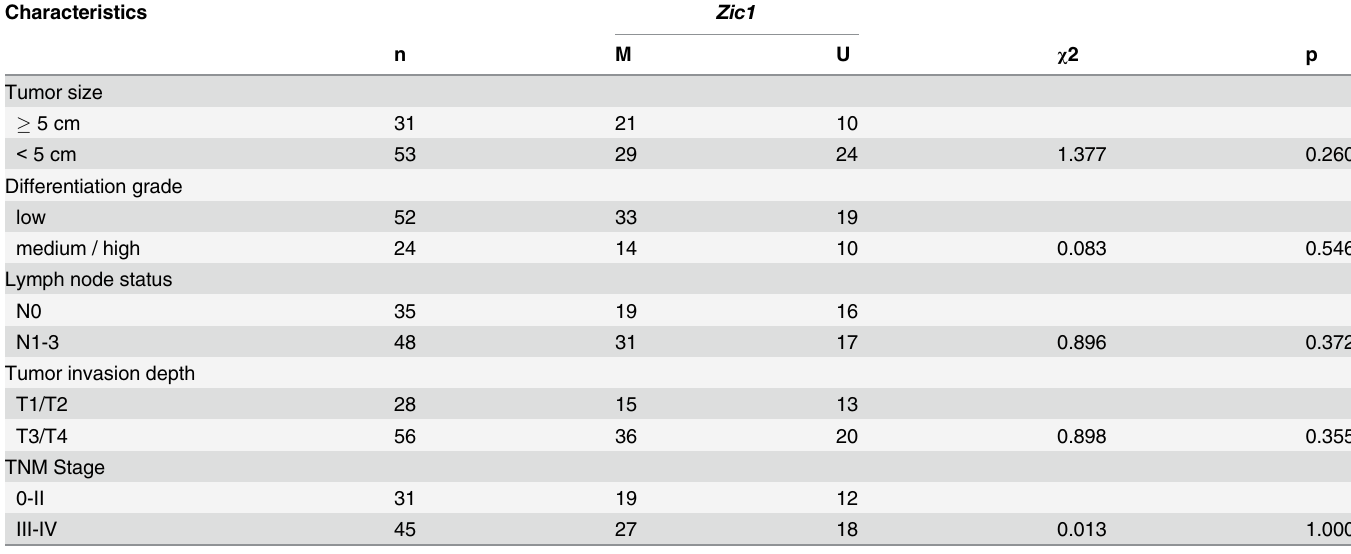
Table 1. Clinicopathological parameters and detection of Zic1 hypermethylation in plasma from gastric cancer (GC) patients.